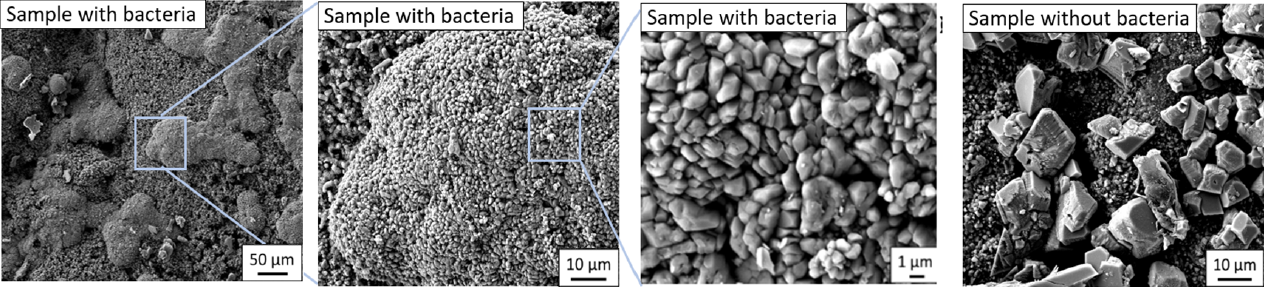
Figure 2. SEM images of the formation of new structures on the surface of cement paste (secondary electron detector).